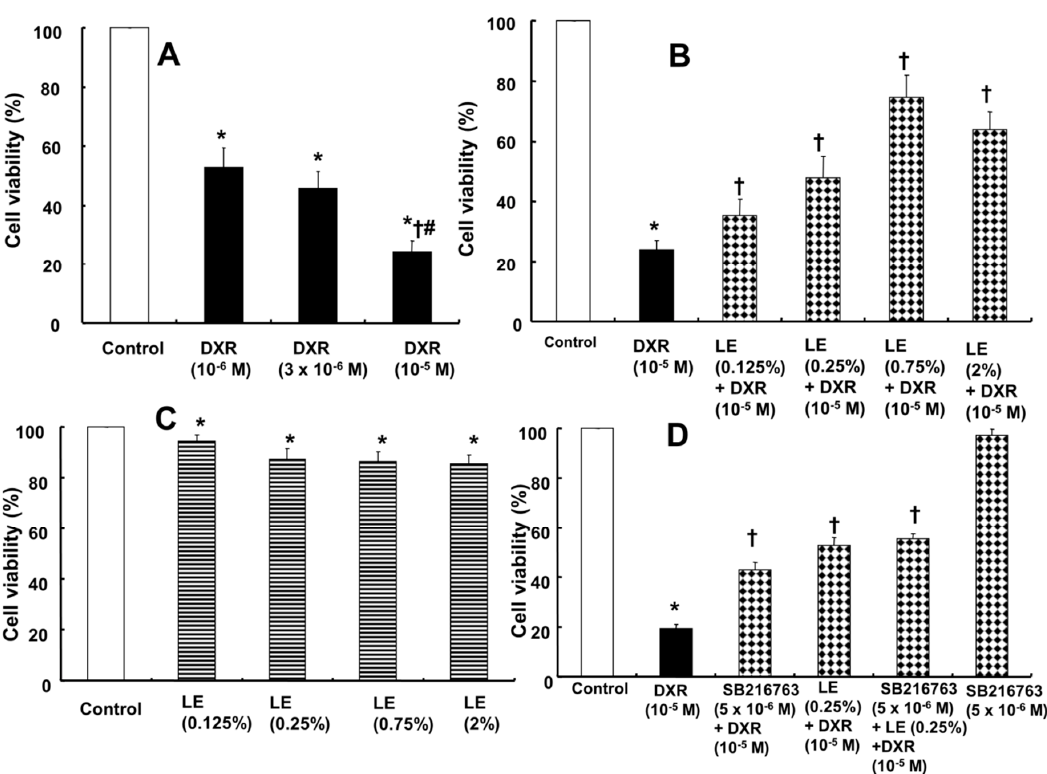
Figure 1. Effects of Intralipid ® (lipid emulsion, LE) and SB216763 alone and in combination on the doxorubicin (DXR)-induced decreased viability of H9c2 rat cardiomyoblasts as determined by the